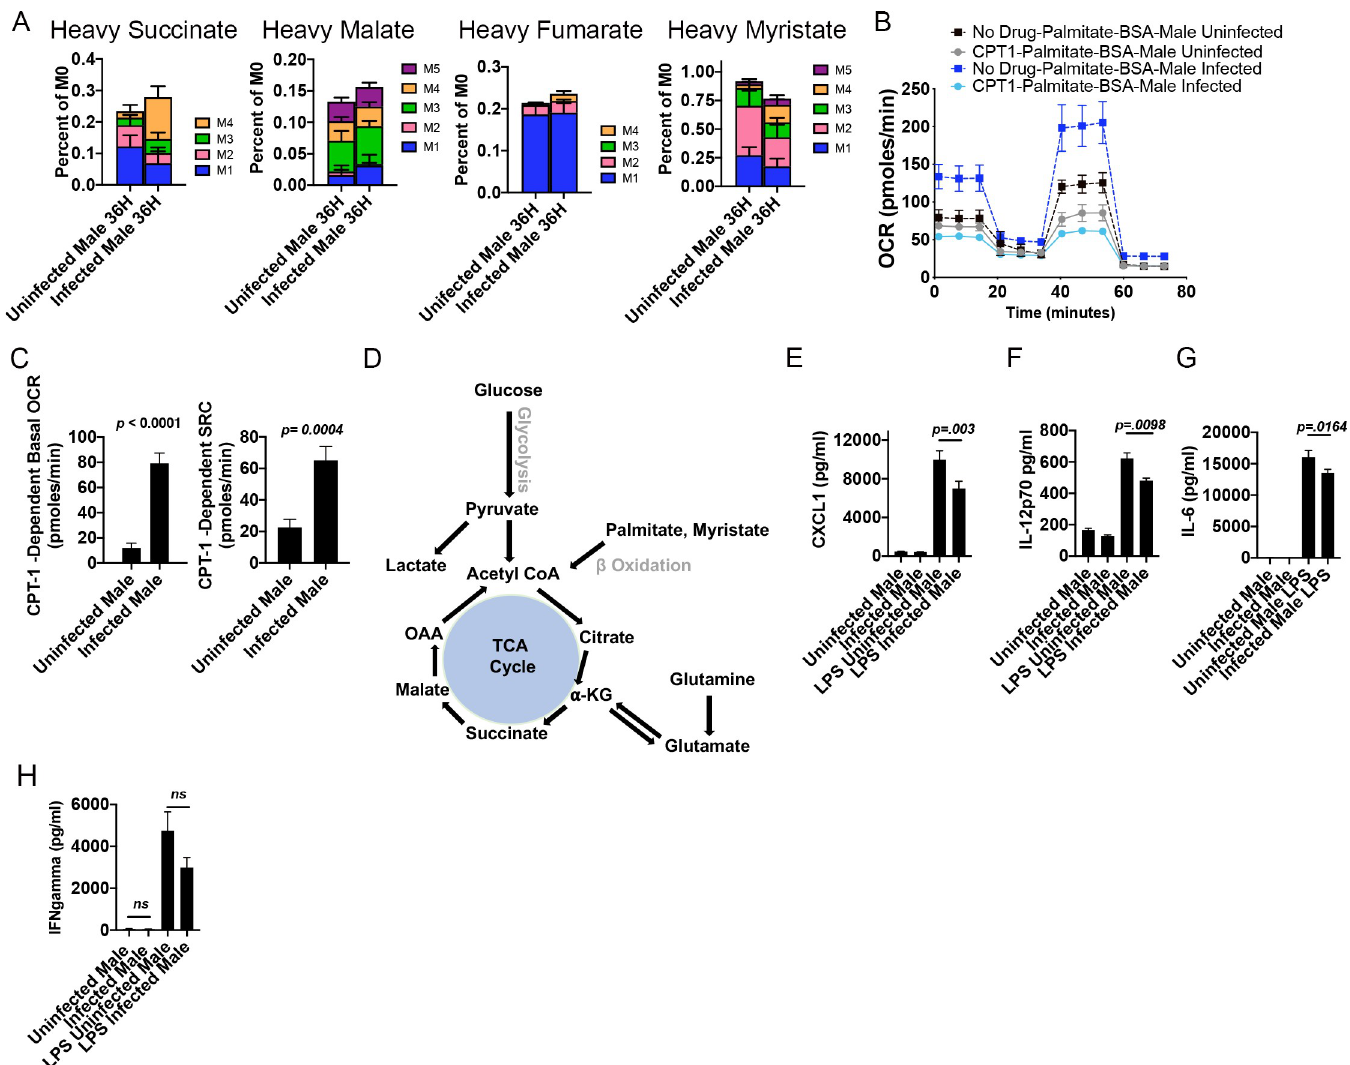
Fig 3. S . mansoni infection induces fatty acid oxidation and lowers chronic inflammatory factors in male ApoE -/- male mice. (A) Macrophages from control and S . mansoni infected ApoE -/- mice were differentiated with M-CSF in a 7-day culture with normal glucose and serum, and then switched to 13 C-labeled palmitate in dialyzed serum for 36 hours followed by metabolic flux analysis (B-C) BMDM were differentiated with M-CSF in a 7-day culture with normal glucose and serum, and then switched to glucose limited media with Palmitate-BSA as the carbon source followed by Seahorse analysis of OCR and SRC in the presence of the CPT-1 inhibitor etomoxir. (D) Schematic of glucose, glutamine, and palmitate inputs into the TCA cycle. (E-H) Quantification of inflammatory mediators in BMDM supernatants 24 hours post stimulation with LPS. Data are representative of two biologically independent